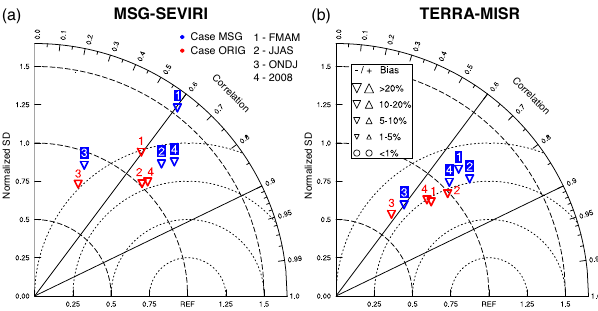
Figure 5. Taylor diagrams comparing the modeled dust opti- cal thickness over North Africa (20 ◦ W–40 ◦ E, 5 ◦ N–40 ◦ N) from ECHAM-HAM runs using the (blue) MSG source mask and (red) original setup with the dust AOT retrieval from MSG-SEVIRI (left panel) and (right panel) the TERRA-MISR AOT (daytime over- passes). Compared are seasonal averages for the months February– May, June–September, and October–January, and the annual aver- age for the year 2008. The inset in each plot shows the scale for the mean